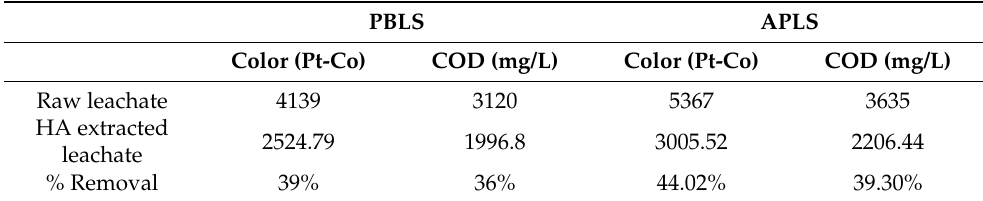
Table 3. Comparison of COD and color removal from leachate based on humic acid